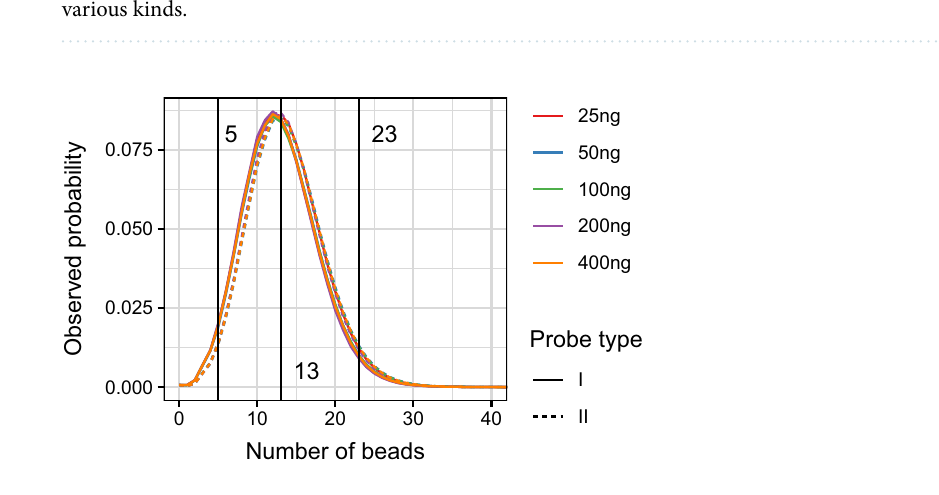
Table 1. Filtering of probes. The filtering was performed sequentially in the order shown. The numbers are conditioned on the filtering order. Steps 2 and 4 were performed to remove probes with registered problems of various kinds.